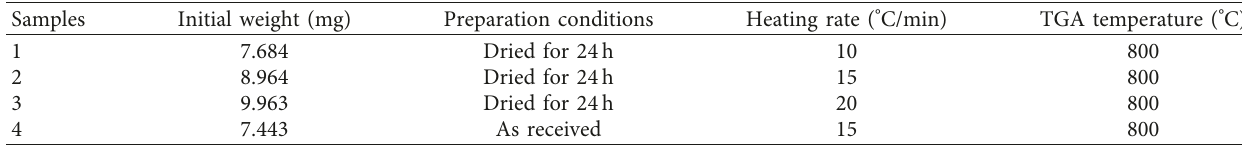
Table 2: Samples descriptions.